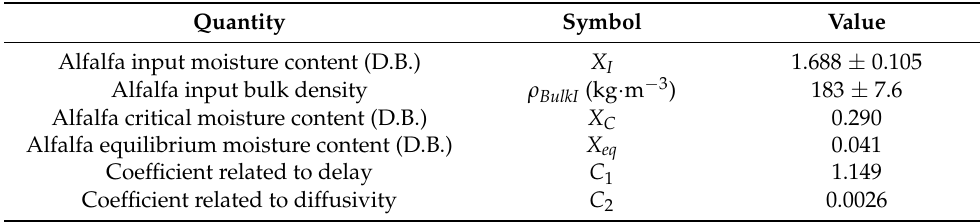
Table 2. Results from experimental drying curve.